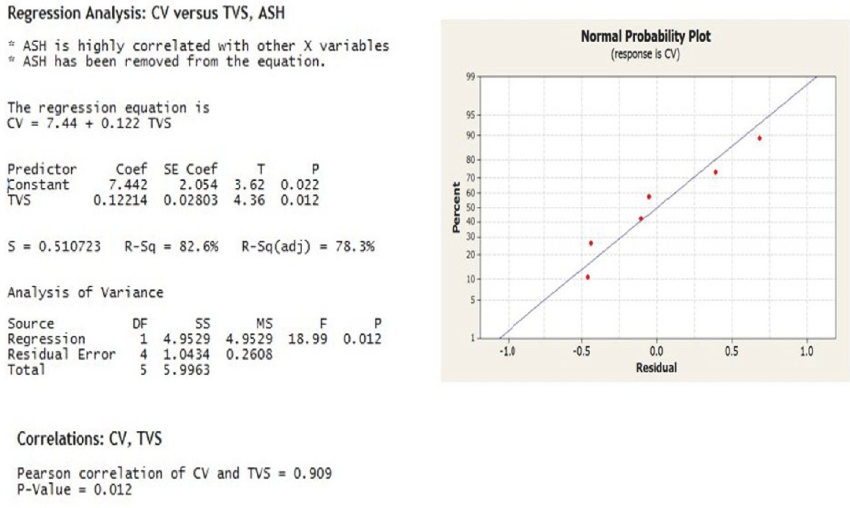
Figure 4: Correlation between the CV, TVS, and ASH content of the solid